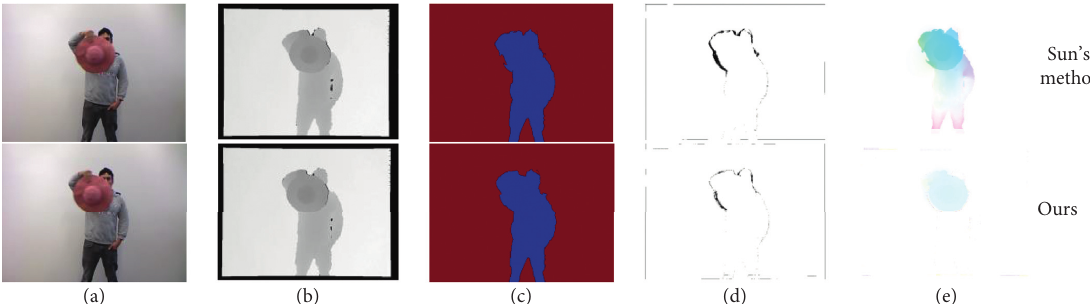
Figure 7: Pose 2 in “Hat” sequence.” Input two consecutive frames about Pose 2 in “Hat” sequence. (a) RGB images. (b) Depth images. (c) Segmentation K � 2. (d) Occlusions. (e) Motion.